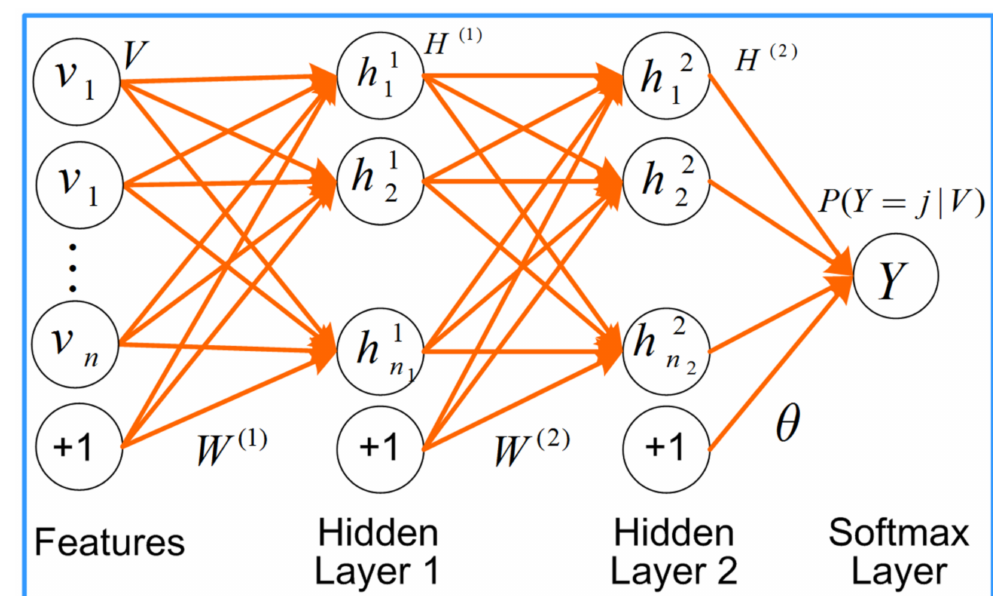
Figure 3. SSAE emotional